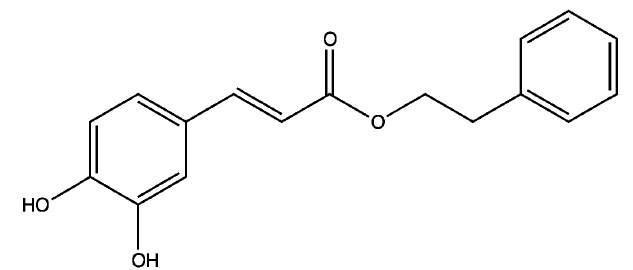
Figure 1. Structure of caffeic acid phenethyl ester